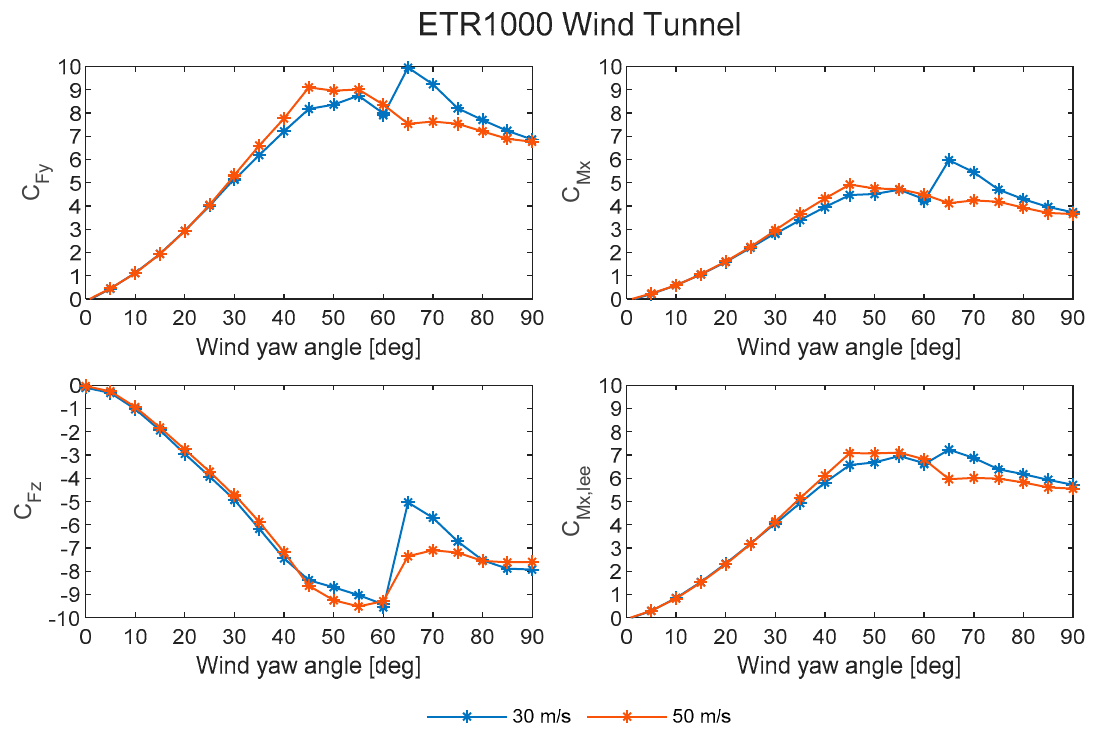
Figure 6. Aerodynamic force coefficients as a function of yaw angle. Wind tunnel test: wind speed 30 m/s and 50 m/s; train: ETR1000; scenario: STBR.